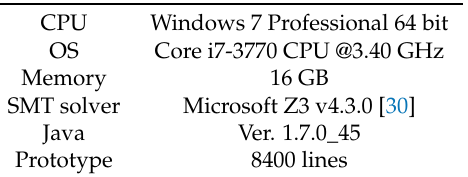
Table 2. Environment of verification.